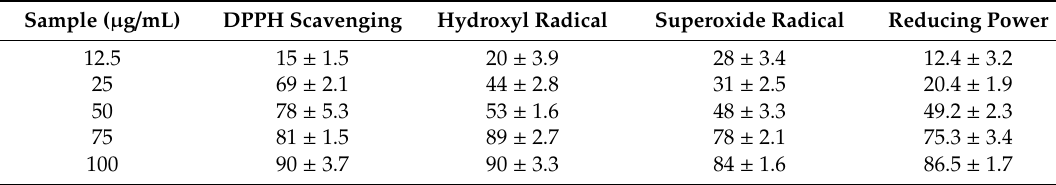
Table 7. Antioxidant activity of cell free extract isolated from L. lactis